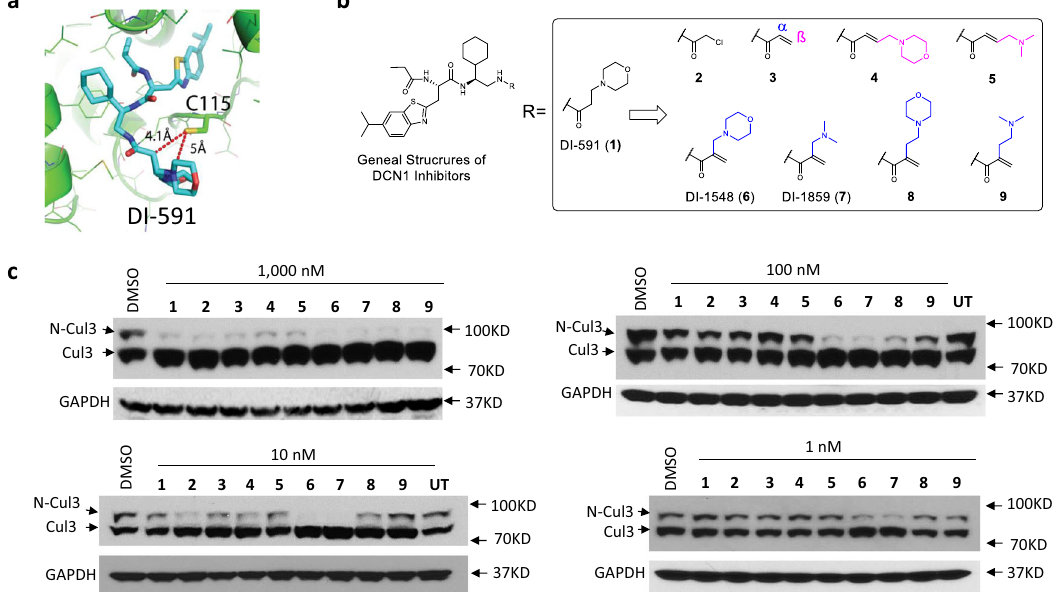
Fig. 1 Structure-based design and initial cellular evaluation of covalent inhibitors of DCN1. a Cocrystal structure of DCN1 (green) and DI-591 (cyan). b Chemical structures of designed and synthesized covalent inhibitors of DCN1. c Inhibition of cullin 3 neddylation by compounds 1 – 9 . Osteosarcoma U2OS cells were treated by nine DCN1 inhibitors at 1000, 100, 10, or 1 nM for 24 h. Protein levels of neddylated cullin 3 (N-Cul3) and unneddylated cullin 3 (Cul3) were examined by western blotting analysis with GAPDH as the loading control. Representative images of two independent experiments are shown and original images are provided as a Source Data fi